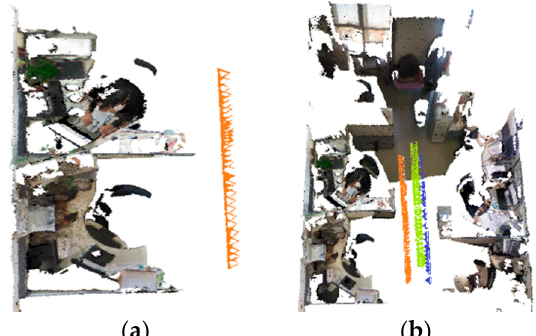
Figure 4. Relative positions of the three Kinects.